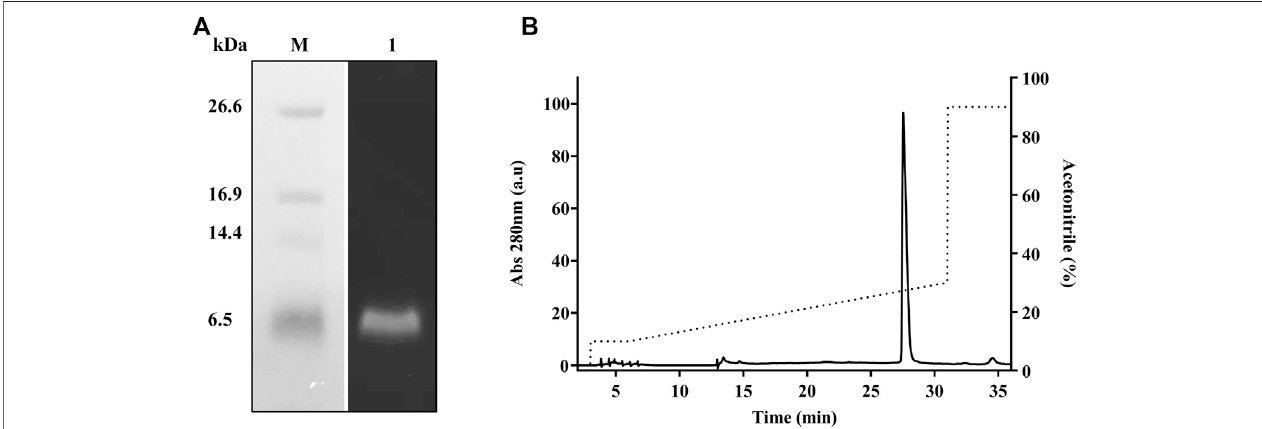
FIGURE 4 | Purity analysis of TrMgTx produced by the two-step puri fi cation protocol. (A) Western blot of the sample eluted from the RP-HPLC column ( Figures 3C,D )usingHRPconjugatedanti-Hisprimaryantibodies. LaneM :low-molecular-weightproteinmarker, lane1 :TrMgTxafter RP-HPLC puri fi cation. (B) TrMgTx eluted from the RP-HPLC column ( Figures 3C,D ) was loaded on C 18 analytical column and eluted with a gradient of 10 – 30% acetonitrile over 25 min (dotted line, right axis). The absorbance was measured at 280 nm (left axis). Single peak indicates TrMgTx. Purity was calculated as [(area under the peak of interest)/(cumulated area under all peaks) × 100] and is shown in Table 1 .